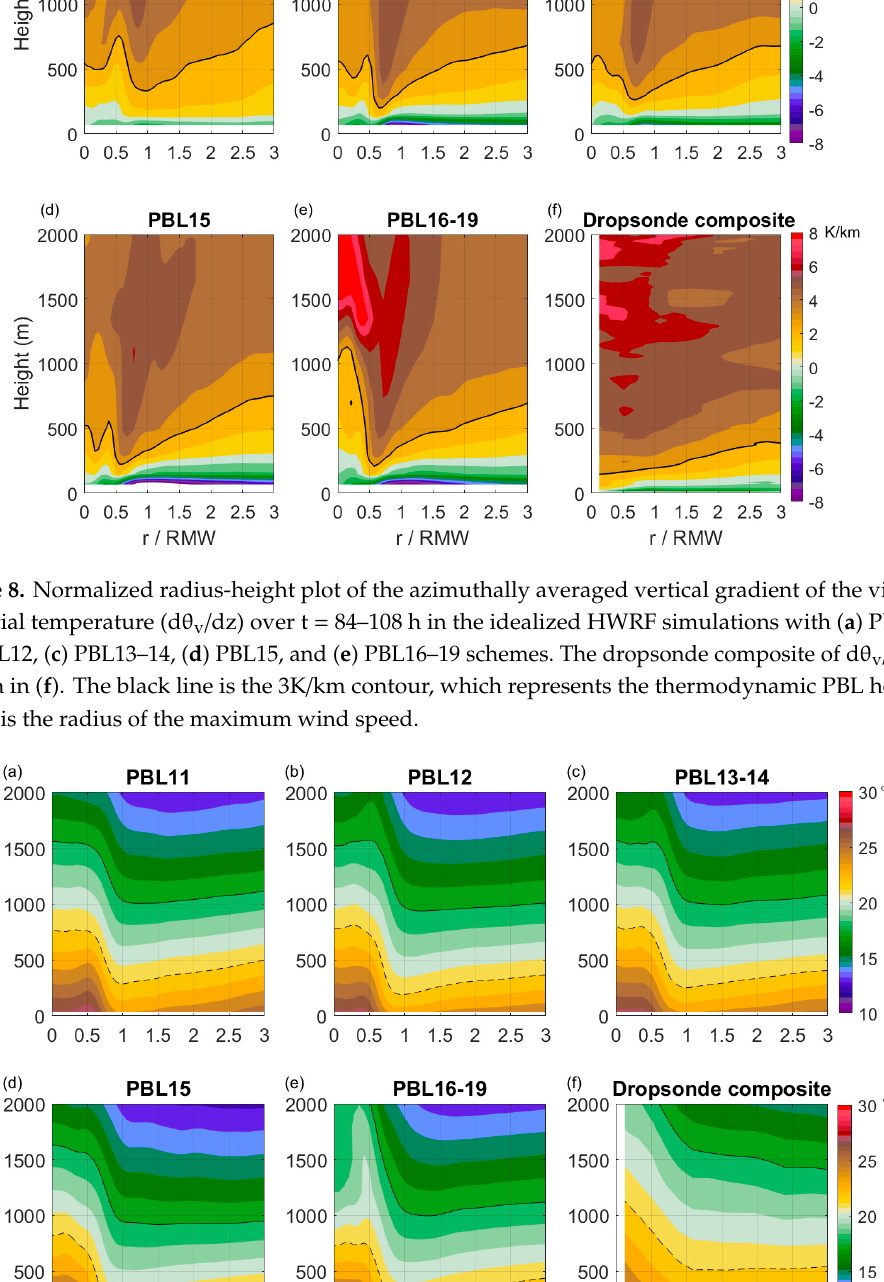
Figure 10. Normalized radius ‐ height plot of azimuthally averaged specific humidity (< q >) over t = 84–108 h in the idealized HWRF simulations with ( a ) PBL11, ( b ) PBL12, ( c ) PBL13 ‐ 14, ( d ) PBL15, and ( e ) PBL16 ‐ 19 schemes. The dropsonde composite of (< q >) is shown in ( f ). The black solid and dashed lines are the 15 g/kg and 20 g/kg contours, respectively. RMW is the radius of the maximum wind speed.